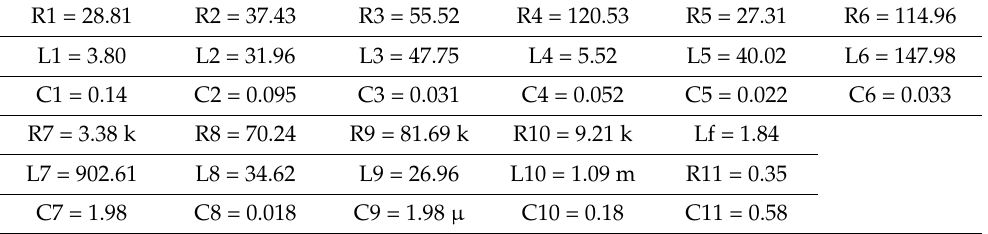
Table 4. Lumped component values of the equivalent circuit model (R in Ω , C in pF and L in